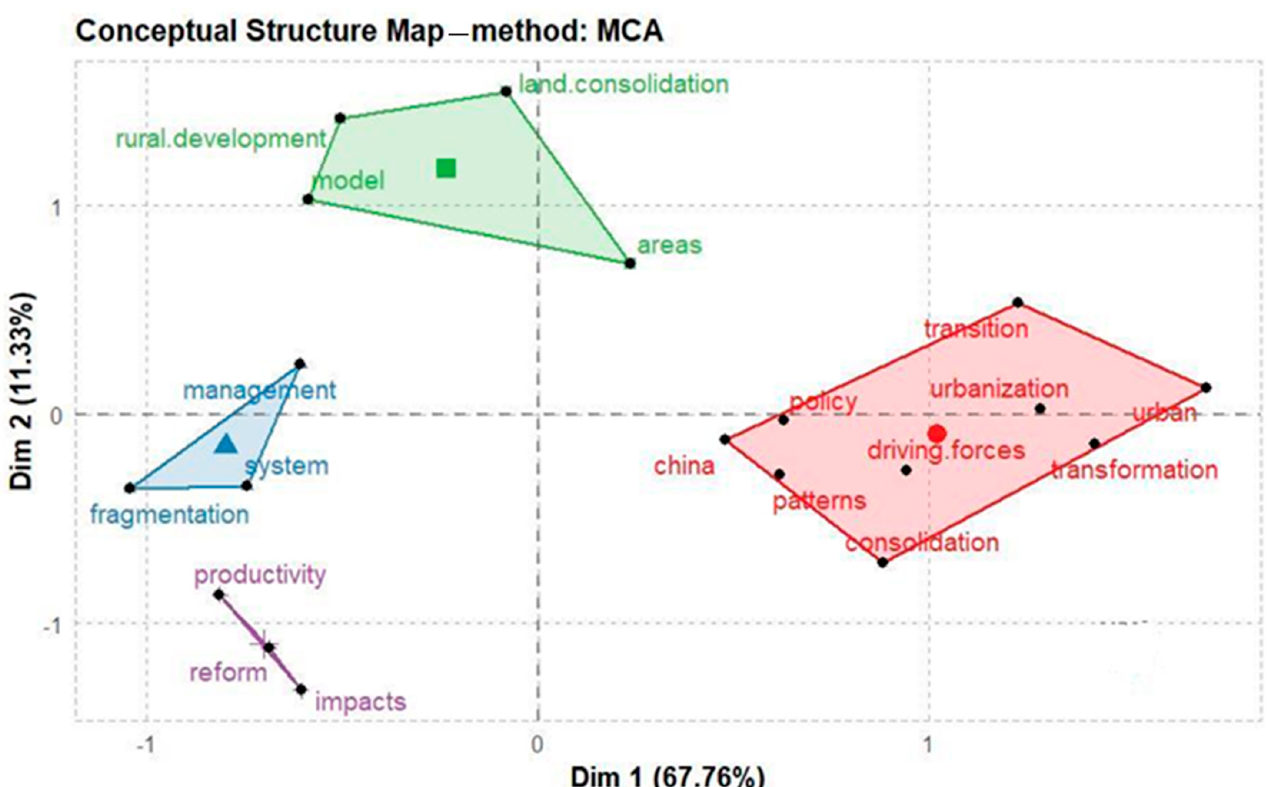
Figure 9. Multiple correspondence analysis of high − frequency keywords in land consolidation and rural revitalization from 1950 to 2021.